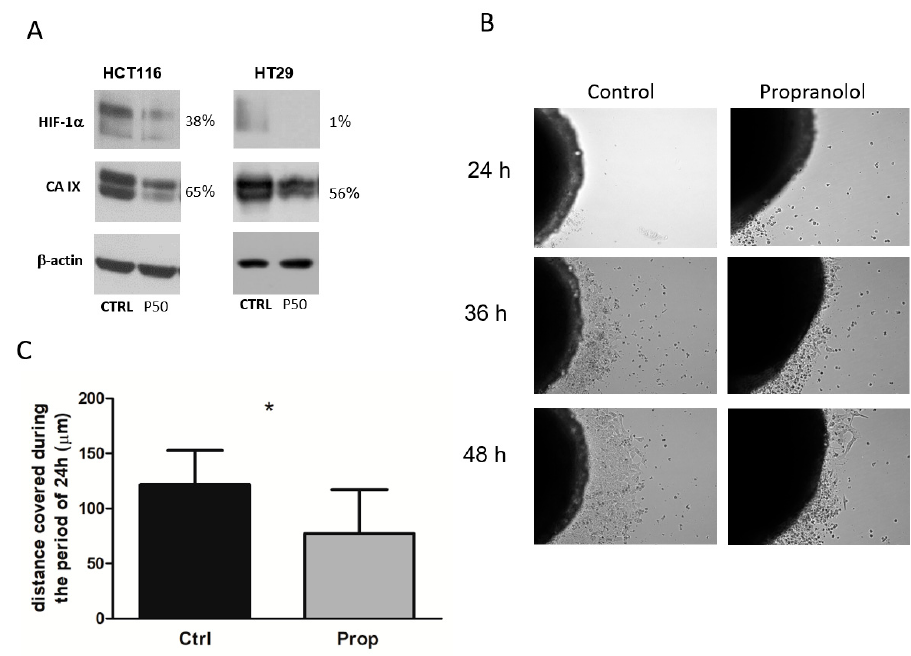
Figure 4. Propranolol decreases level of HIF1 α and CA IX in 3D spheroids and affects migration properties of colorectal cancer cells. ( A ) Western blot analysis of CA IX and HIF1 α levels. Spheroids were treated with beta-blocker propranolol for 5 days, lysed and expression of CA IX and HIF1 α